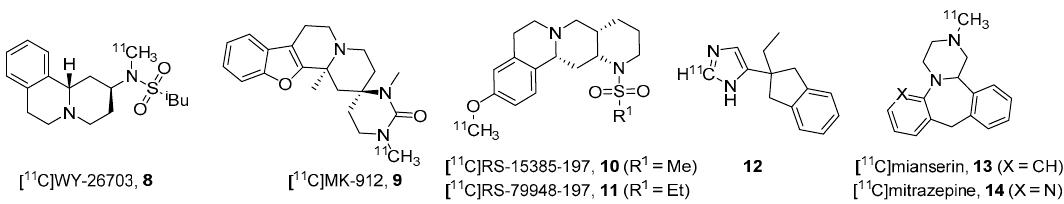
Figure 2. Various classes of α 2-ARs antagonist radiotracers.